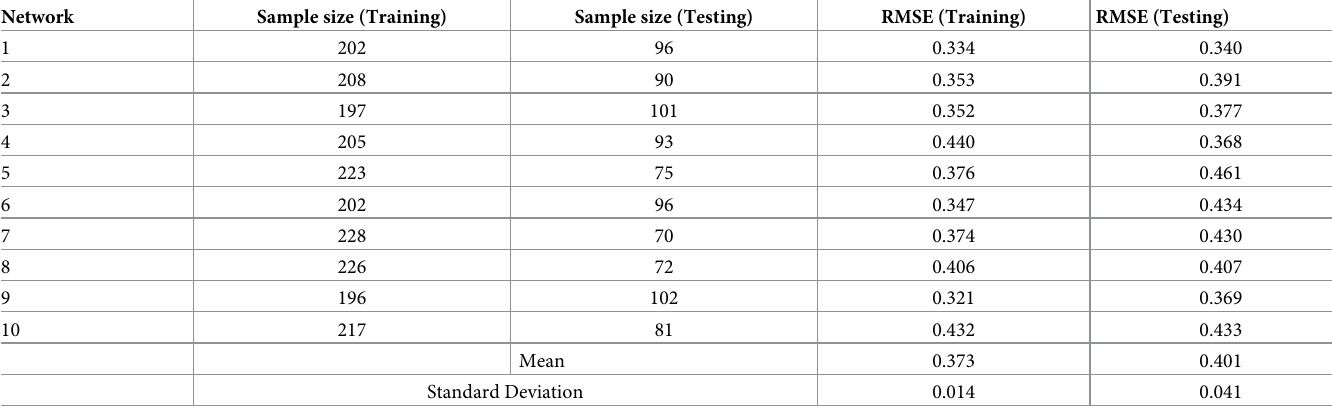
Table 8. RMSE values of artificial neural networks (N = 298).